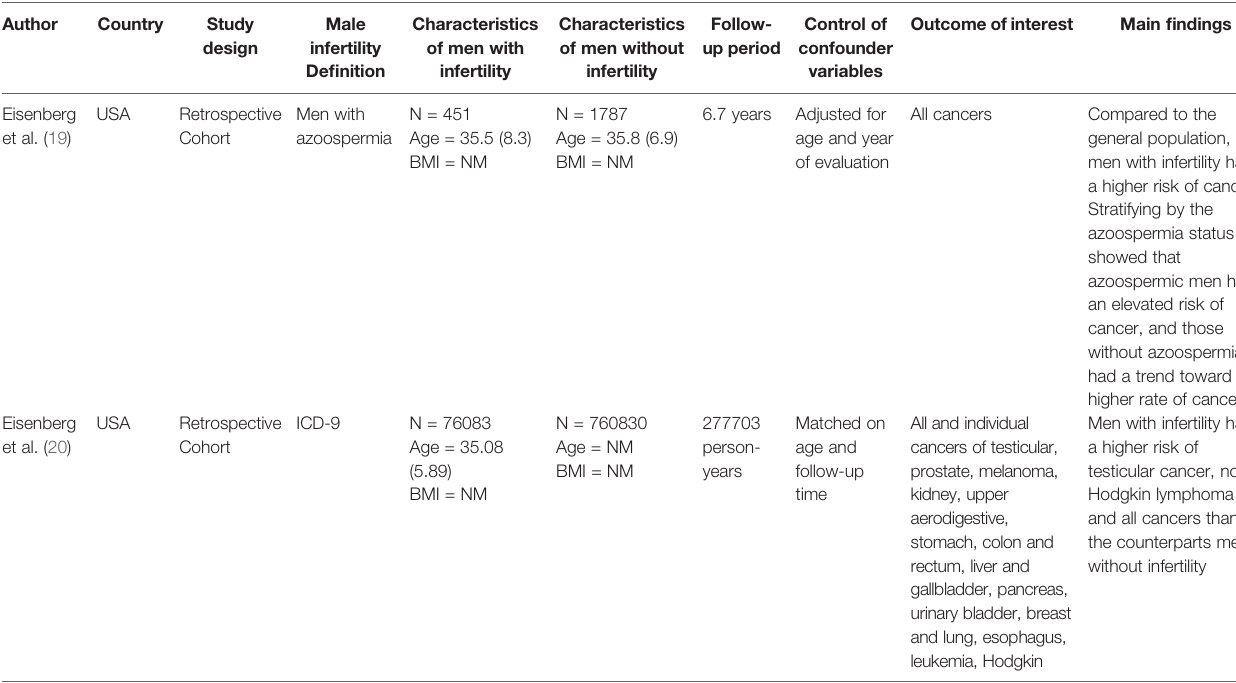
TABLE 1 | Systemic review of the included studies in